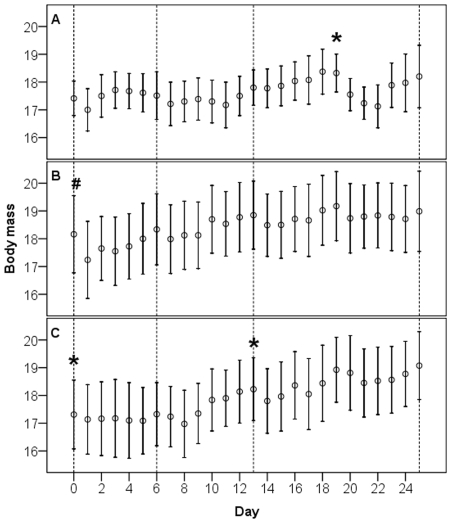
Body mass changes in European Robins Erithacus rubecula over the course of the infection experiment.Body mass is presented as the mean (±2 SE) of all individuals in each treatment group for each day over the course of the experiment. Challenge time points are marked with stars (*) for the human C. jejuni isolate 00F4382 and a bracket (#) for the Song Thrush isolate 00-4:268. Blood sampling time points are noted with hatched reference lines at days 0, 6, 13, and 25 post-infection.